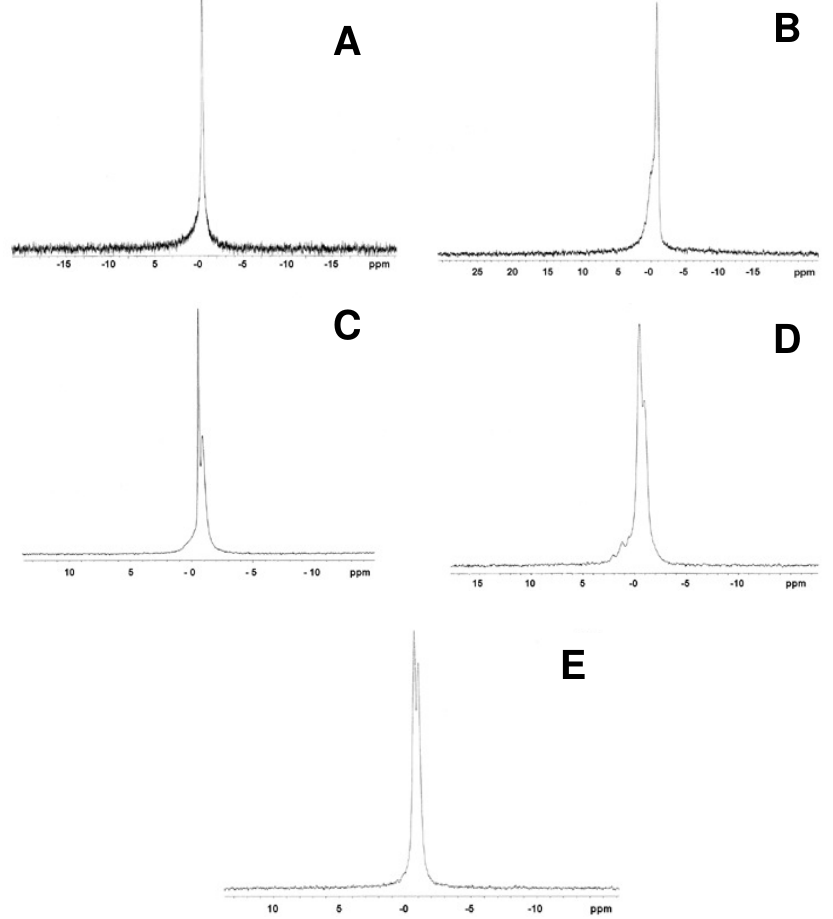
Figure 14. 31 P-NMR spectra at 20 °C of the systems formed by DMPC/DHPC q = 2 ( A ), DMPC/DHPC q = 2 + 10% mol C14-Cer ( B ), DMPC/DHPC q = 2 + 10% mol C24-Cer ( C ), DMPC/DHPC q = 2 + 20% mol C14-Cer ( D ) and